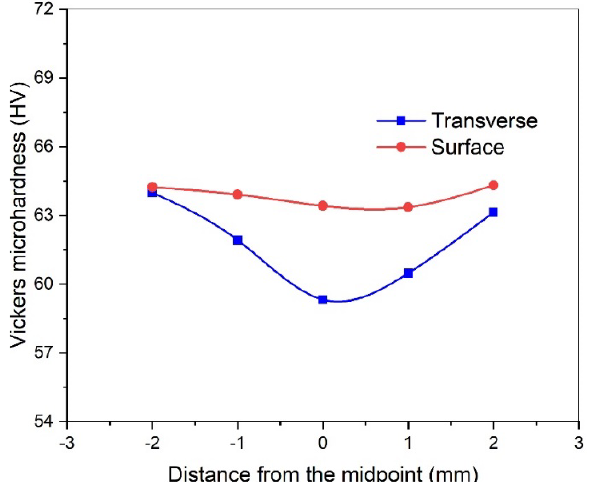
Figure 4. The profile of hardness values of extruded Mg AZ31B at different area